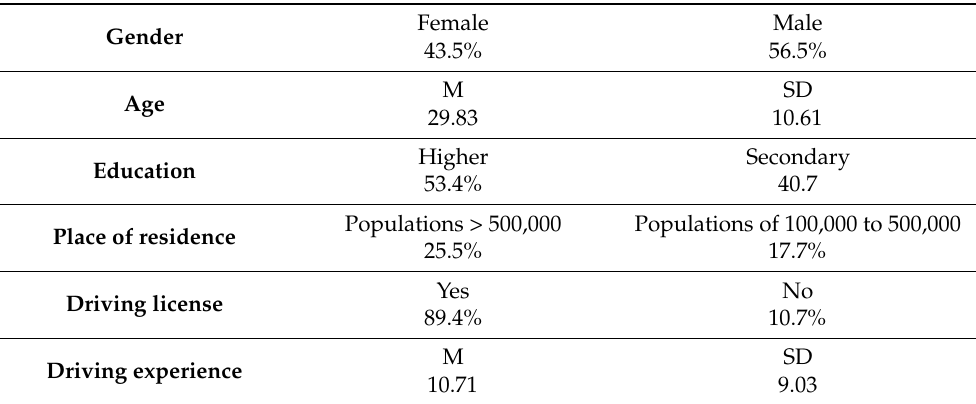
Table 1. Participants’ profile